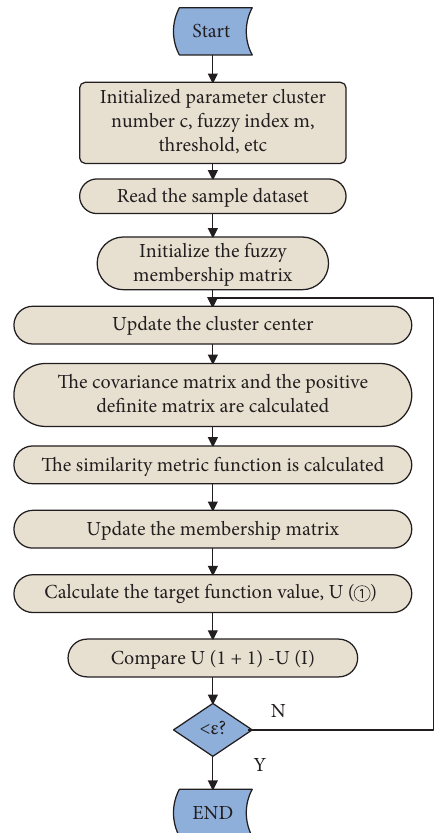
Figure 2: Flowchart of GK